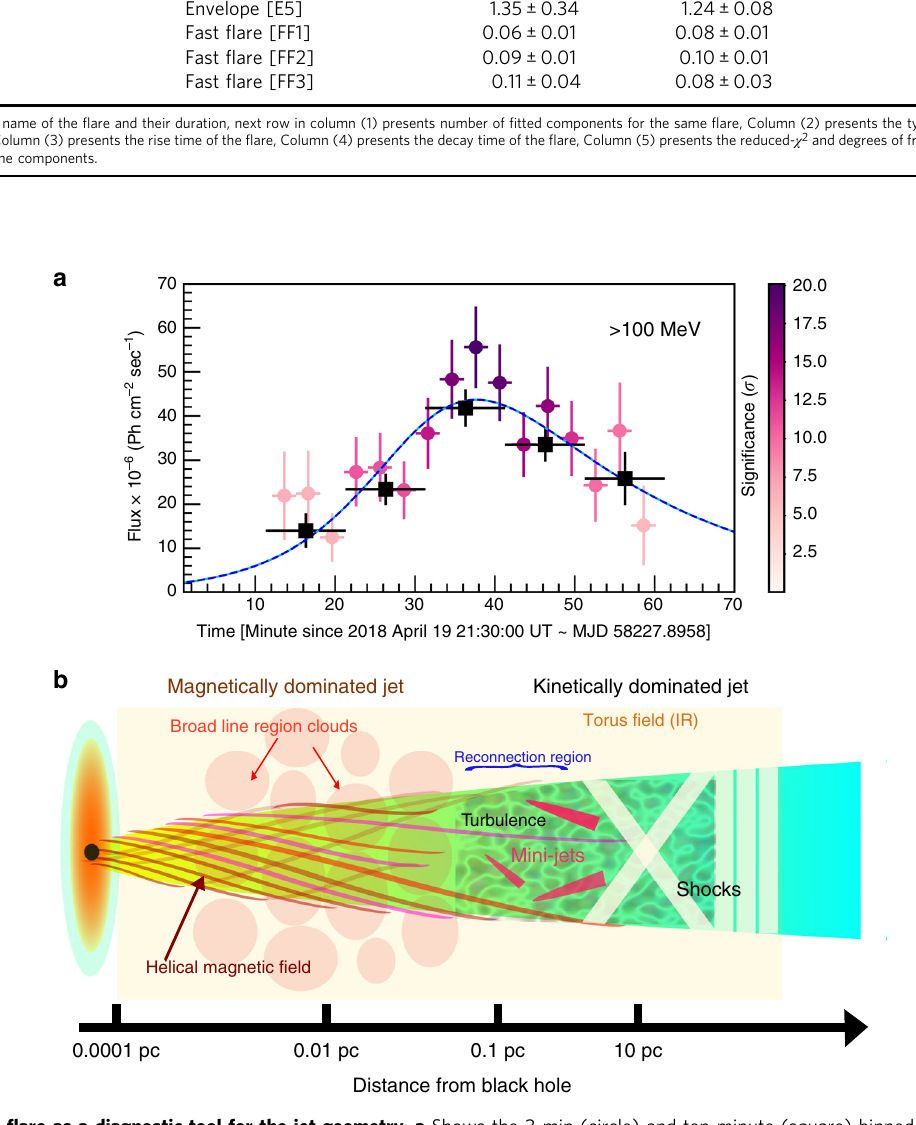
Fig. 2 Minute-scale fl are as a diagnostic tool for the jet geometry. a Shows the 3-min (circle) and ten-minute (square) binned light curves measured during the orbit wherein a strong rapid variability of the order of a few minutes with high signi fi cance (4.7 σ ) was observed. During this orbit, 3C 279 was found to be highly inconsistent with the constant fl ux having p -values 0.002 ( χ 2 -test) and 10 − 5 ( χ 2 -test) for the three-minute and 10-min binned light curves, respectively. Hence, the best- fi t function to the 3-min binned light curve is deduced using the sum of two exponentials represented by the dashed cyan-blue line. Notably, the error bars in the light curve represent 1 σ uncertainty and the signi fi cance of each 3-min bin is colour-coded. b Shows a proposed sketch of the inner jet of a blazar, explaining the peak-in-peak light curve with reference to the jet-in-jet magnetic reconnection model. In this scenario, the magnetic fi eld fragments into small plasmoids that interact and grow into monster plasmoids within the reconnection region. Subsequently, these massive plasmoids lead to the formation of mini-jets, which produce optically thin minute-scale gamma-ray fl ares. These mini-jets are represented in the sketch in magenta. Moreover, the emission from the reconnection region, as a whole, accounts for the observed envelope